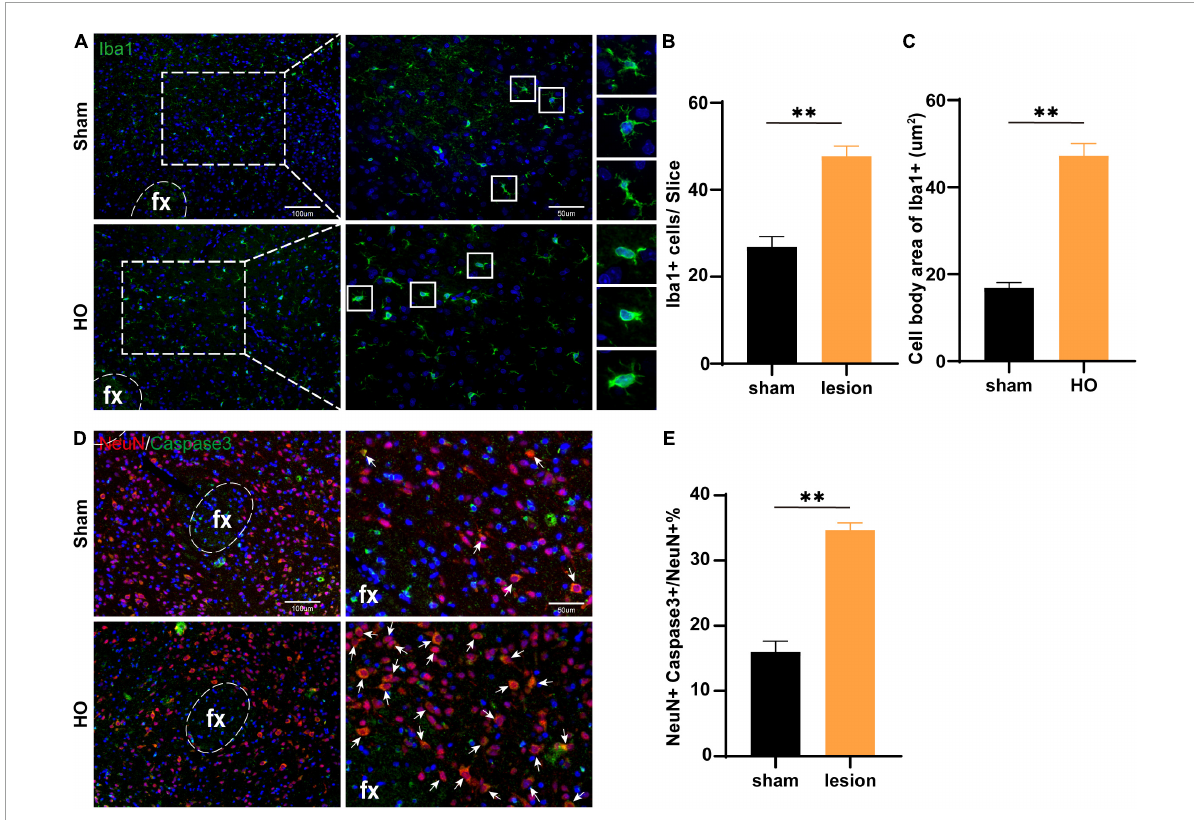
FIGURE6 Microglial cells in the LHA region of obese rats were accompanied by neuronal apoptosis. (A) Immunofluorescence staining of Iba1 + cells. Iba1 (green) and DAPI (blue). Scale bars, 100 µ m for low magnification images and 50 µ m for high magnification images. (B,C) Quantification of Iba1 + cells and the cell body area in the LHA, n = 4–6, ∗∗ P < 0.01 vs. sham-operated group. (D) Immunofluorescence in the LHA: NeuN (red), Caspase3 (green), and DAPI (blue); scale bars, 100 µ m for low magnification images, 50 µ m for high magnification images. (E) Quantification of neuronal apoptosis in the LHA, n = 6, ∗∗ P < 0.01 vs. sham-operated group. All data are presented as the M ± SEM of each